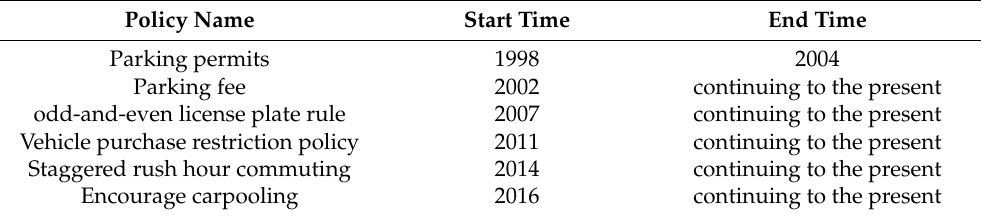
Table 5. Beijing Traffic Management and Control Policy Start and End Times.